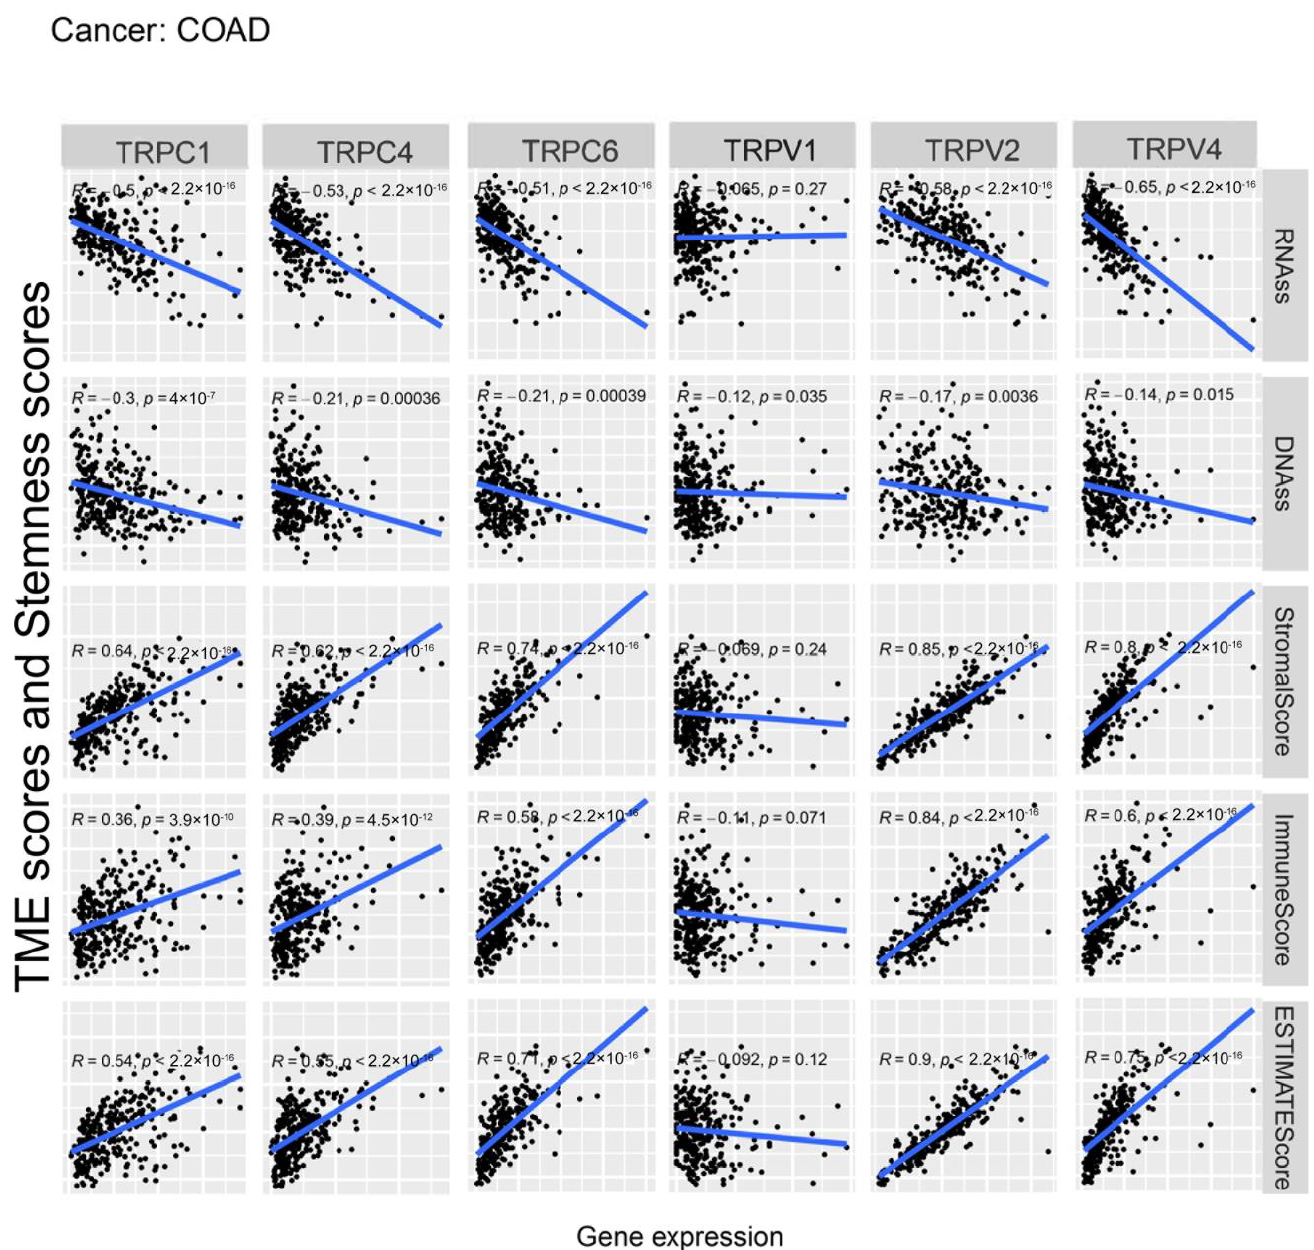
Figure 6. Correlation analysis of the expression of TRP family genes with RNAss, DNAss, stromal score, immune score, and ESTIMATE score in COAD.